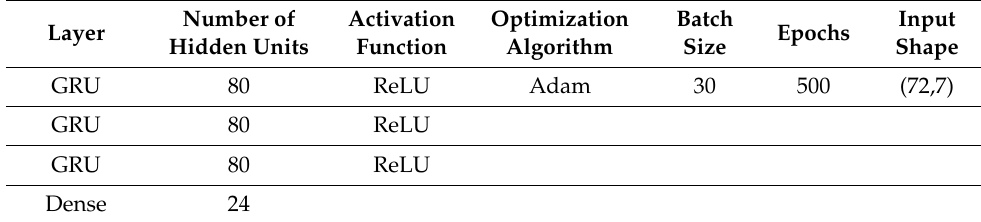
Table 7. Model Architecture for